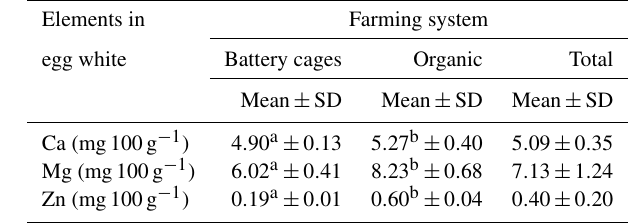
Table 1. Content of Ca, Mg and Zn in egg yolk depending on the farming system. Elements in